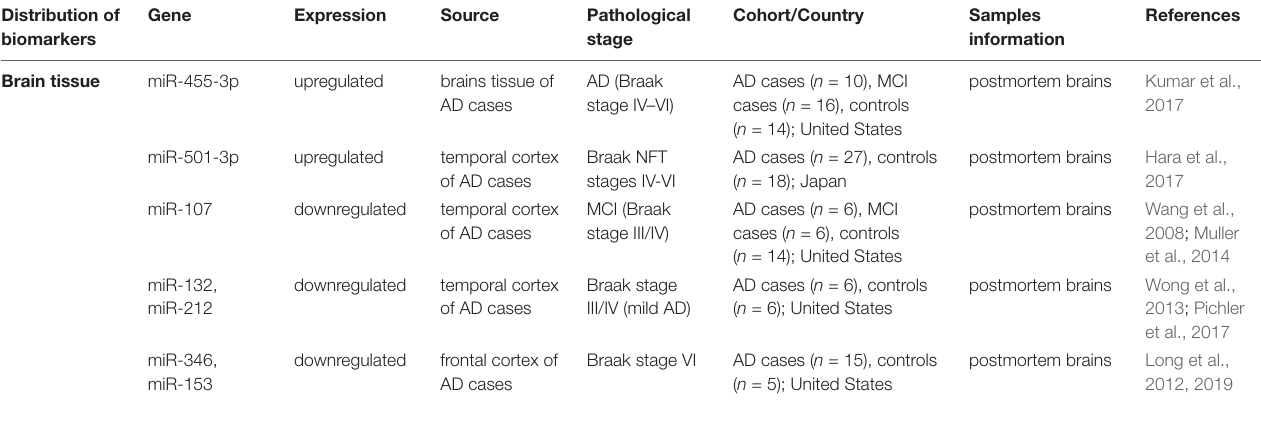
TABLE 2 | Potential targets detected in the brains of AD cases. Distribution of